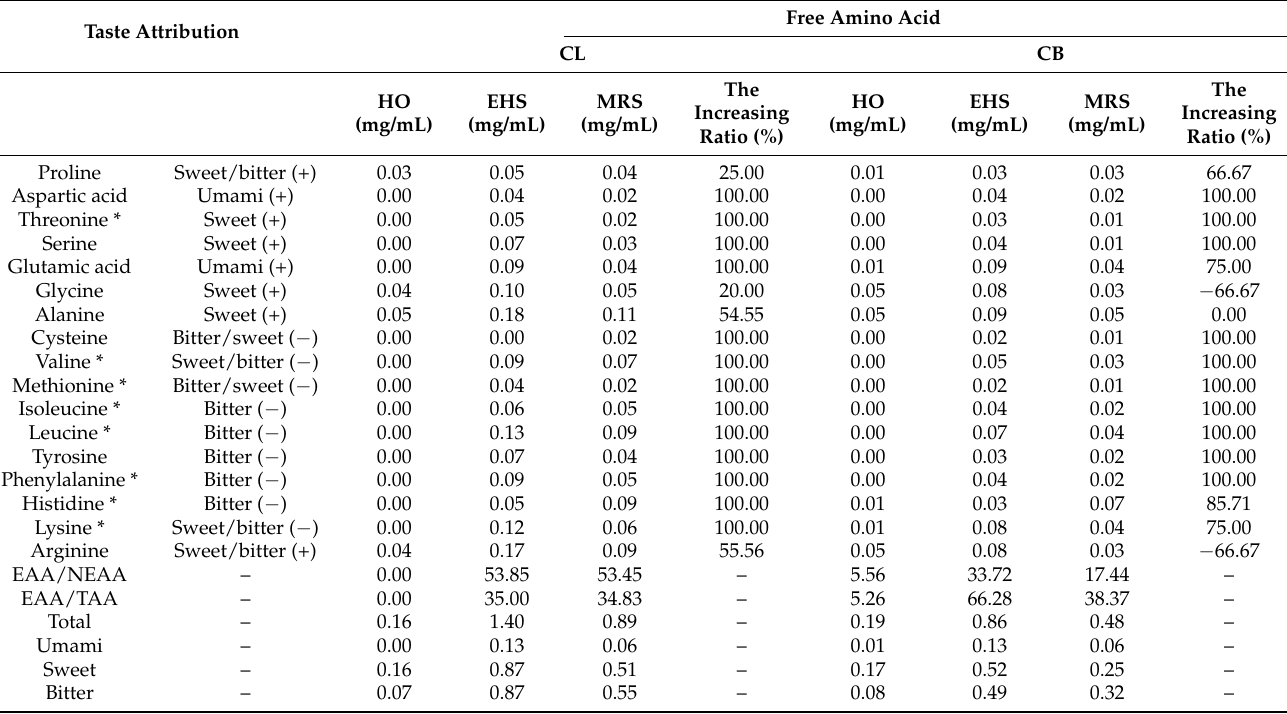
Table 2. Proportion of hydrolyzed amino acid composition, the concentration, and the increasing ratio of free amino